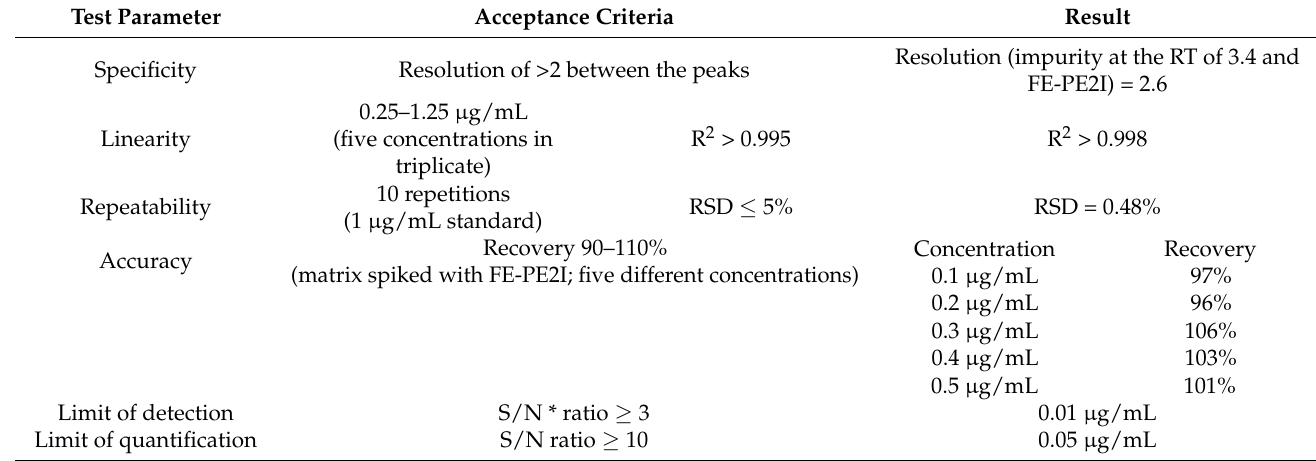
Table 1. Summary of the validation data for the HPLC analysis of [ 18